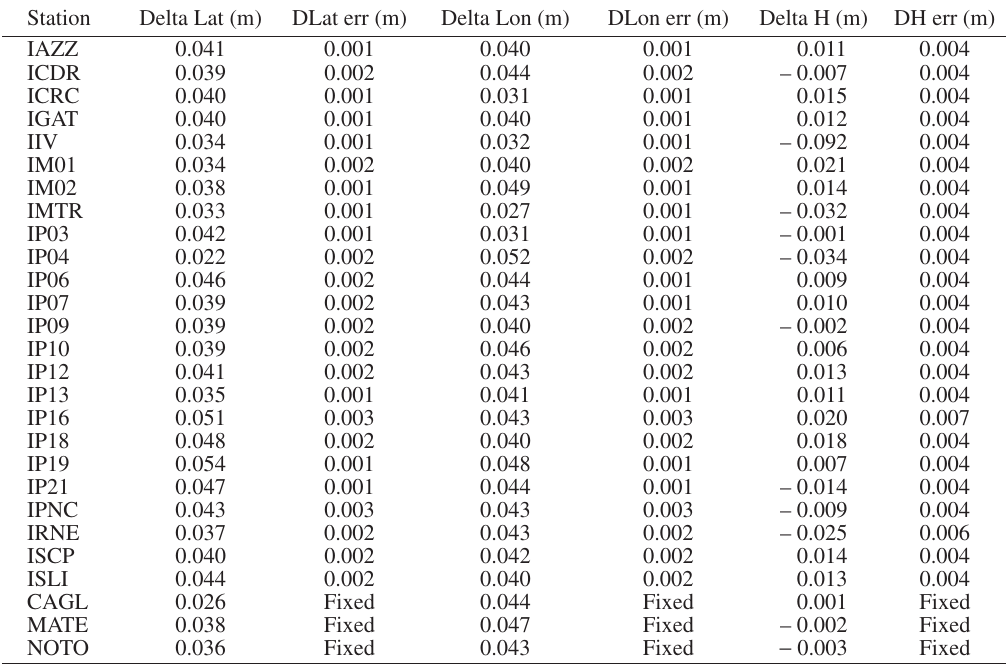
Table V. Coordinate variations between 1998 (epoch 1998) and 2000 (epoch 2000). The average formal errors are about 3 mm for the horizontal component and about 4-5 mm for the vertical